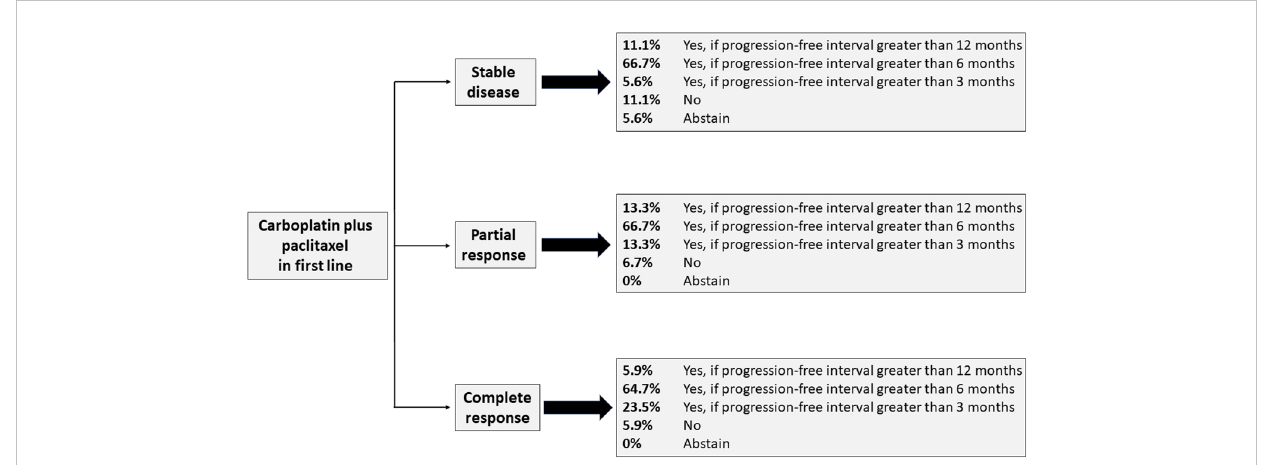
FIGURE 1 Recommendations for re-exposure to carboplatin and paclitaxel according to response to fi rst-line therapy.